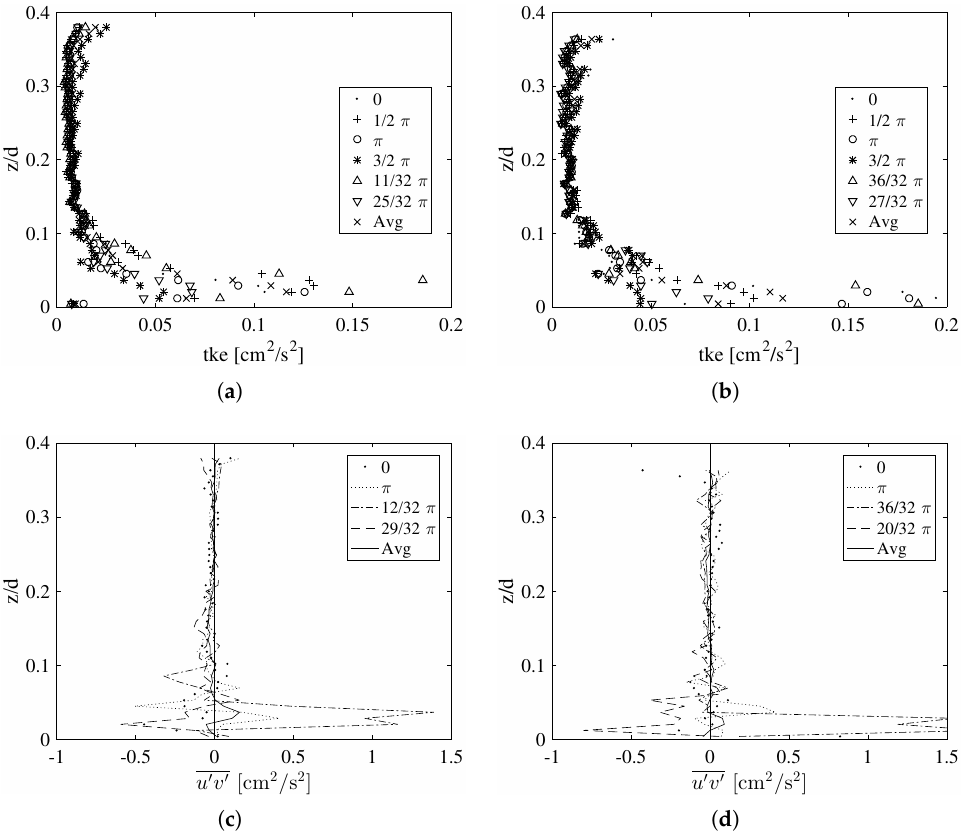
Figure 9. T 9 test ( H = 5.86 m, T = 1.26 s), turbulence phase analysis: ( a ) tke profile at P 1 , L 2 ; ( b ) tke